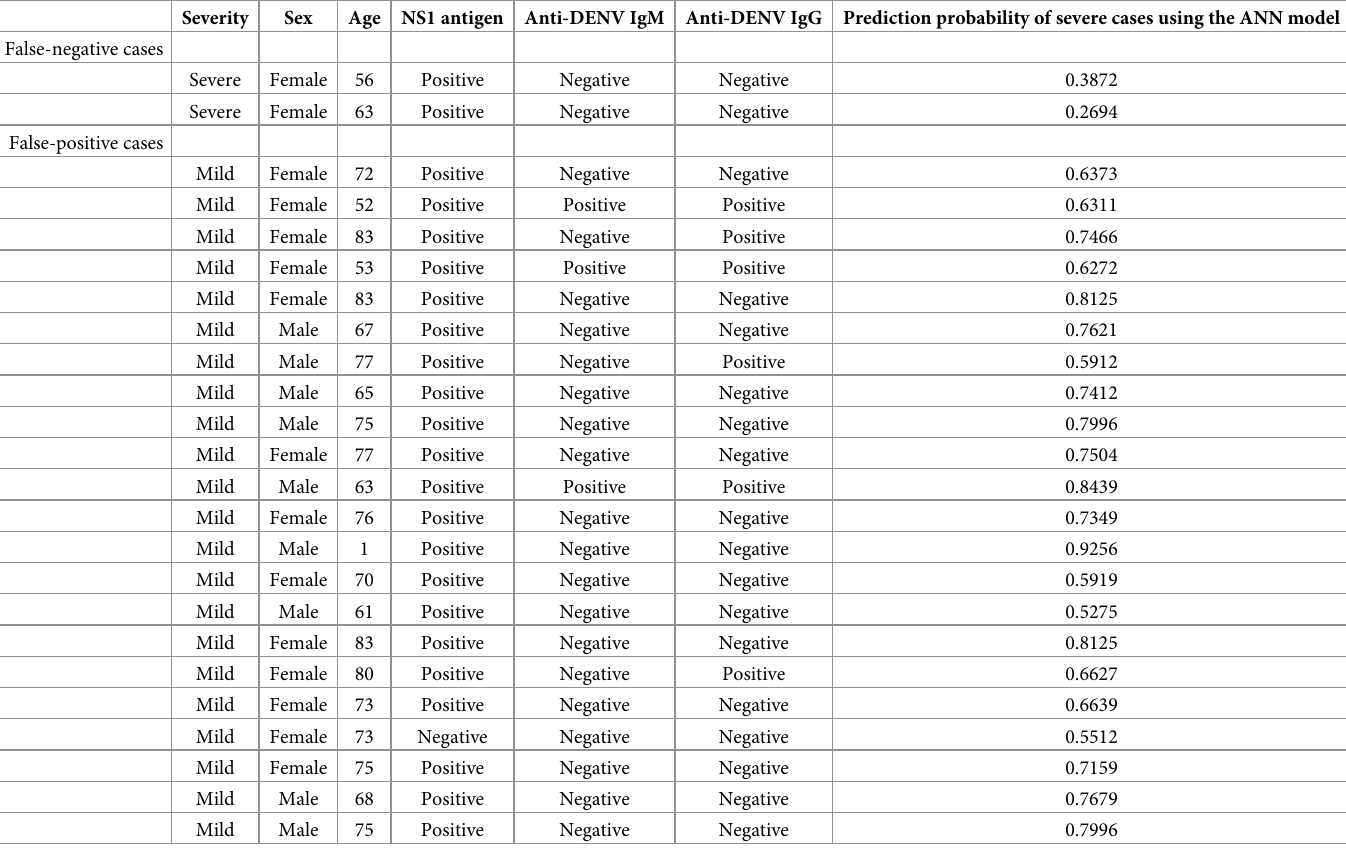
Table 4. Definitions of false-negative and false-positive severe dengue cases in the test dataset, using ANN model prediction. Severity False-negative